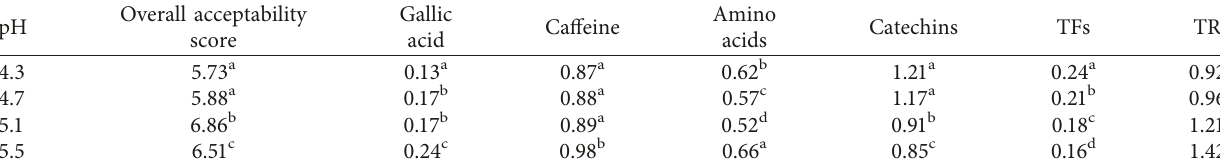
Table 1: Effect of pH on the concentrations of different chemical components (mg · mL − 1 ) and overall acceptability of fermented juices. Overall pH